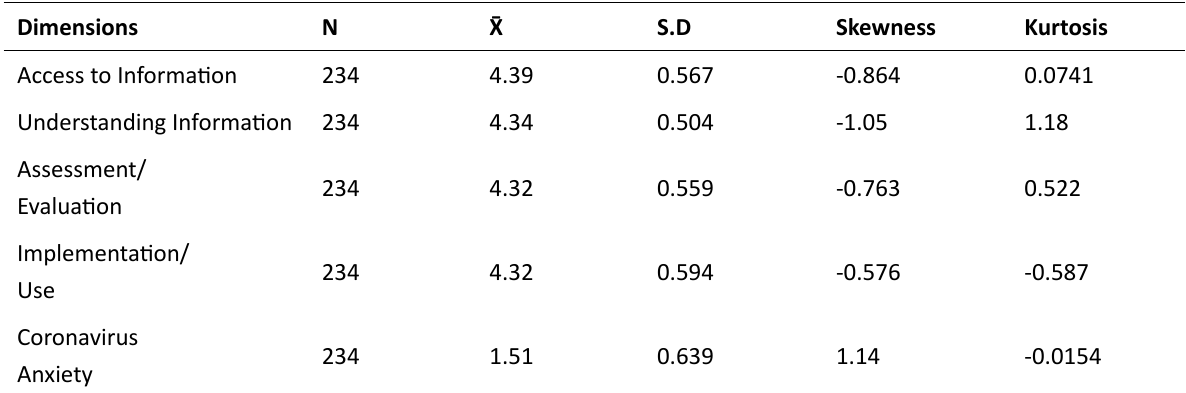
Table 1. The Averages, Skewness and Kurtosis Values of the Health Literacy Sub-Dimensions and Coronavirus Anxiety Levels of the Athletes Participating in the Study